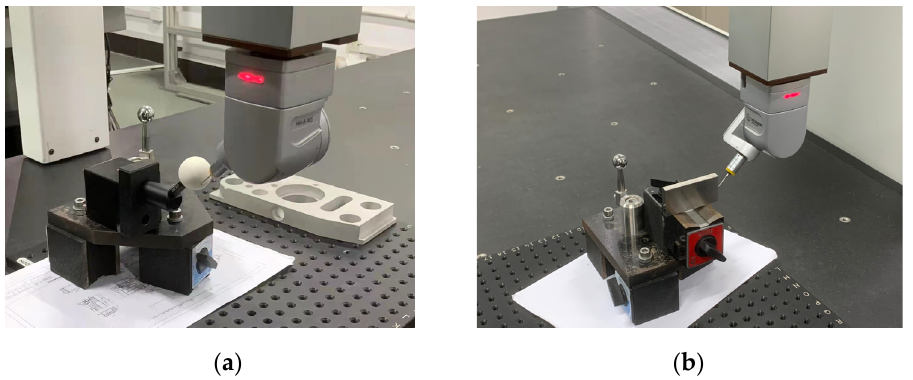
Figure 17. Deviation analysis between the standard sphere model and the scanned point cloud.